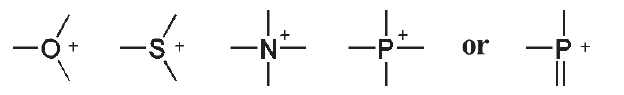
Figure 27. The structure of the growing chain ends in CROP.